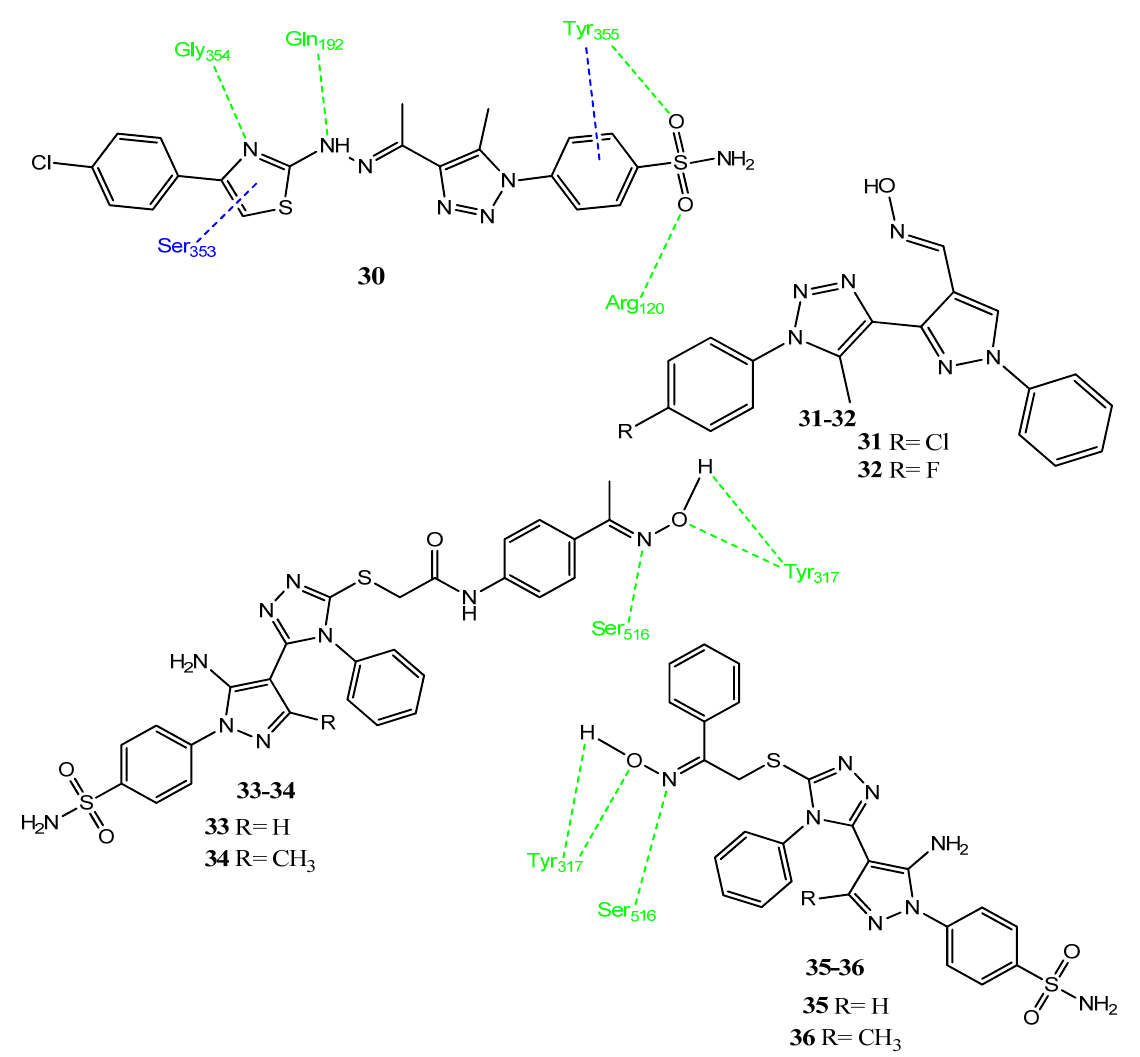
Figure 7. Pyrazole–based hybrid